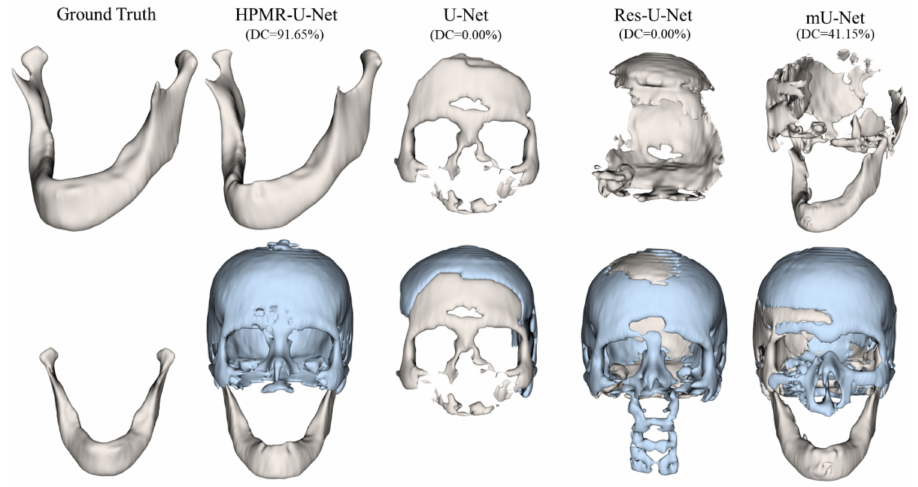
Figure 7. Sample case in the TCIA dataset. White and blue indicate mandible and maxilla, respectively. TCIA has no maxilla ground truth.